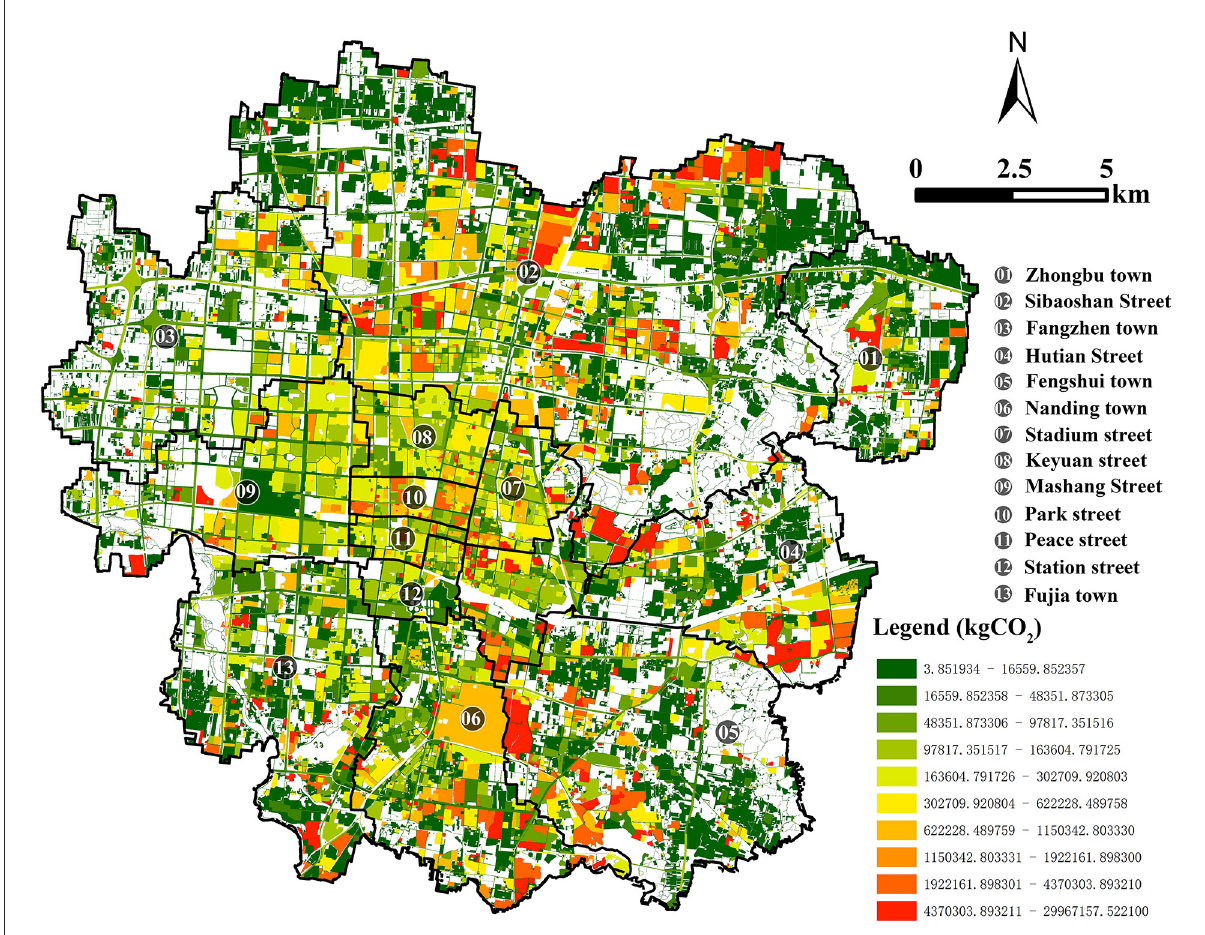
FIGURE4 Carbon emissions map of